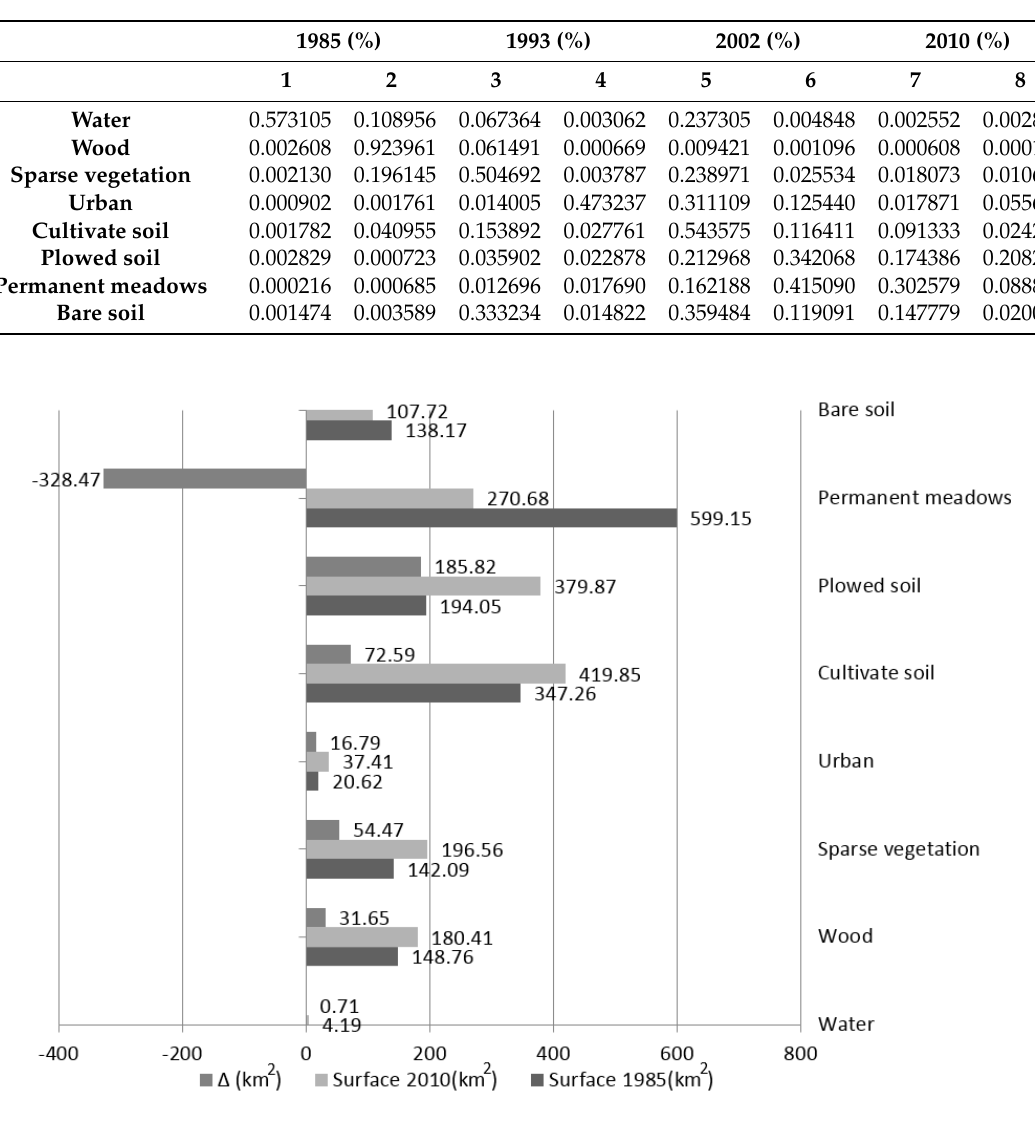
Figure 7. Variation of eight classes between 1985 and 2010.